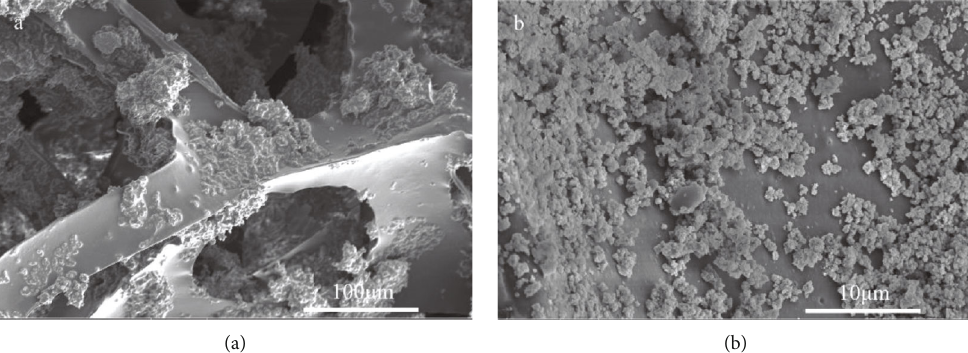
Figure 6: SEM images of the skeleton structure of the modi fi ed sponge (a) and surface pro fi le of the modi fi ed sponge